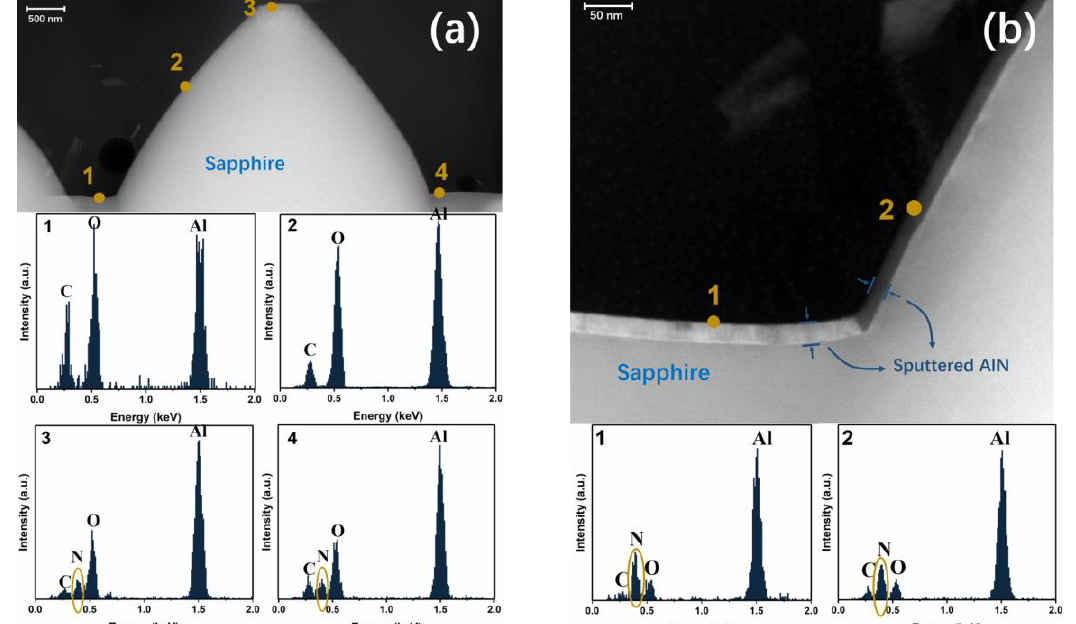
Figure 1. ( a ) The TEM image of the 10 nm sputtered AlON/PSS template and EDX results of four spots. Nitrogen is only found in spots 1 and 4. ( b ) The TEM image of the 25 nm sputtered AlON/PSS template and EDX results of two spots.